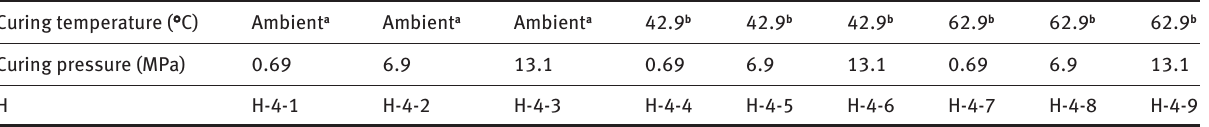
Table 2: Test series I (w/c = 0.4, duration of curing = 48 h). Curing temperature ( ° C)